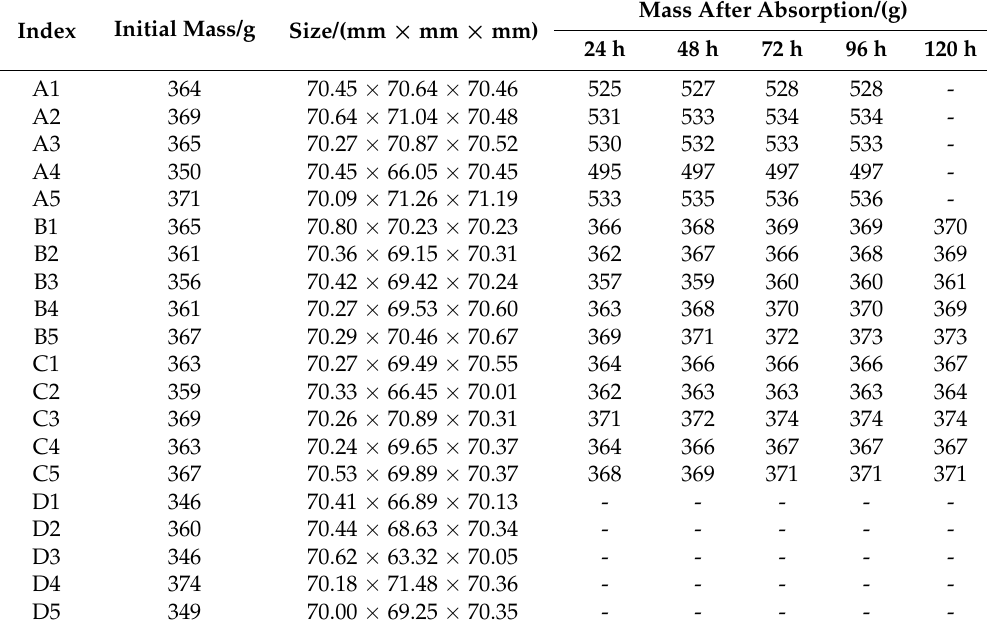
Figure 2. Preparation and image of specimens ( a ) specimen preparation diagram; ( b ) image of hole-containing specimens. Table 1. Size and parameters of specimens.